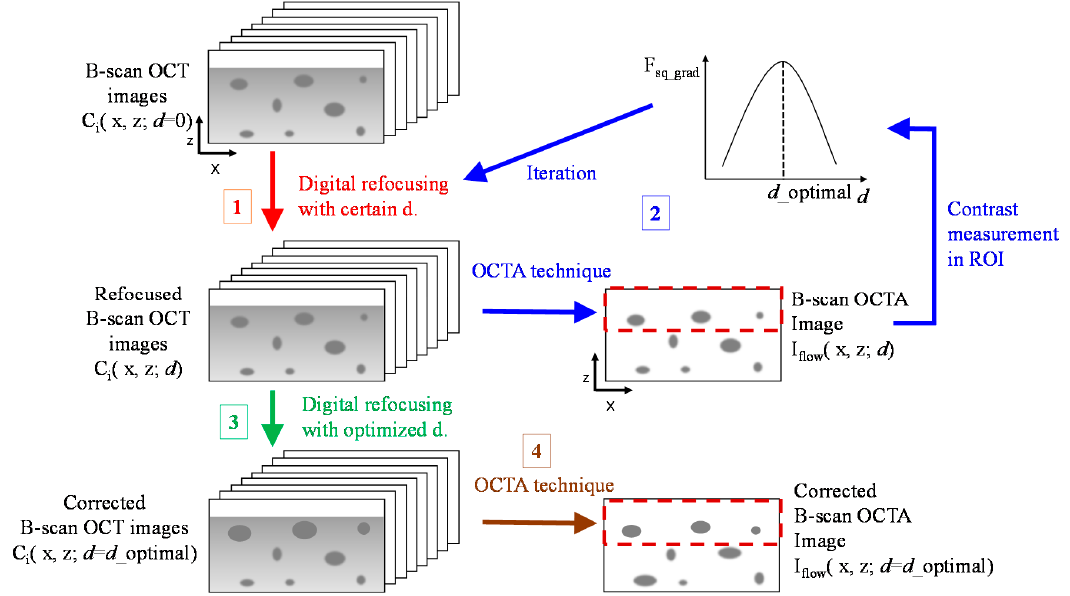
Figure 2. Steps to reconstruct well-focused OCTA images. Complex OCT data are obtained from Fourier transform of the acquired fringes. In the process 2 shown in blue color, the optimal propagation distances, d _optimal, giving the maximum contrast in the OCTA image, are searched for by evaluating the contrast of the OCTA image in the ROI (region of interest) while inserting numerous d values. The round structures in the B-scan OCT images represent vascular structures in the mouse brain.